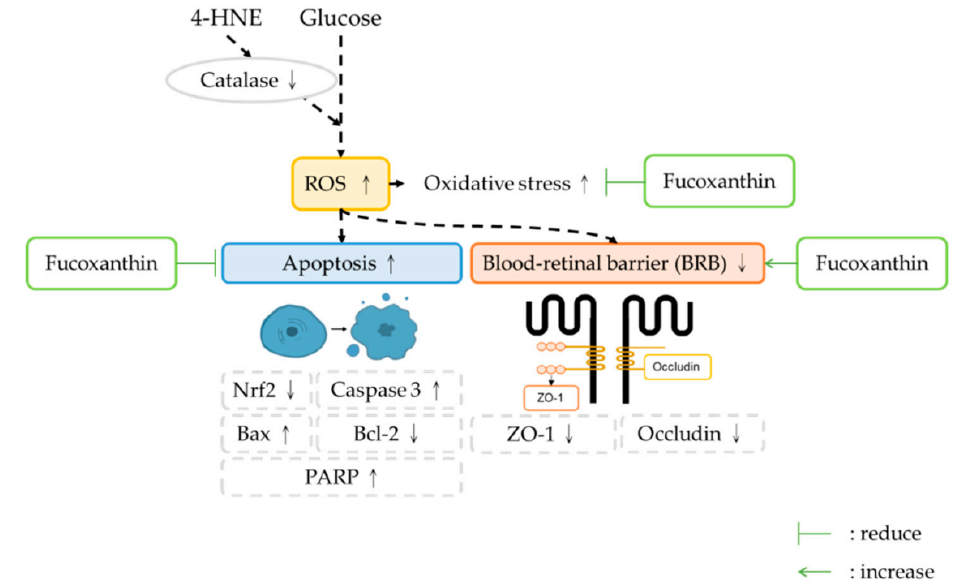
Figure 8. Schematic representation of the protective e ff ect of fucoxanthin on the 4-HNE- and high glucose-induced ARPE19 cell damage. The reduction of the ROS and the completeness of the blood–retinal